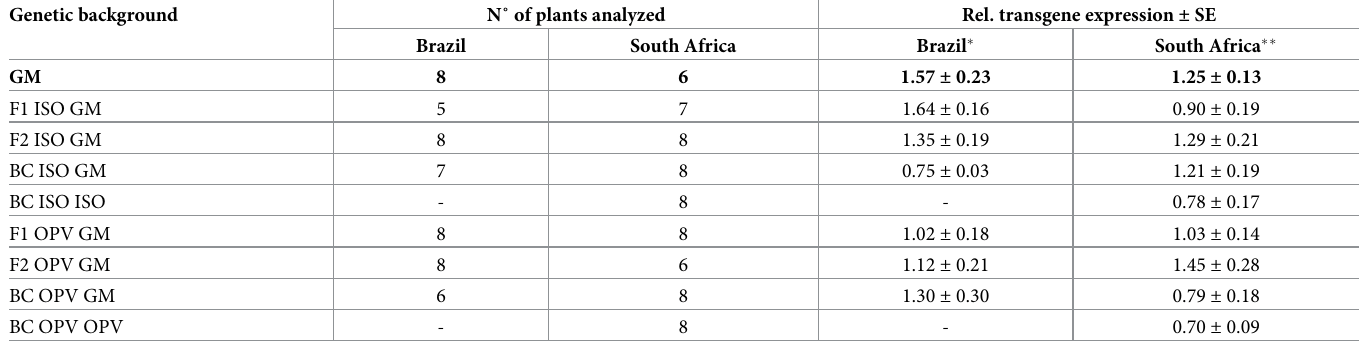
Table 1. Number of analyzed maize plants, mean and standard error ( ± SE) of the relative transgene expression in different genetic backgrounds from Brazil and South Africa. Genetic background N˚ of plants